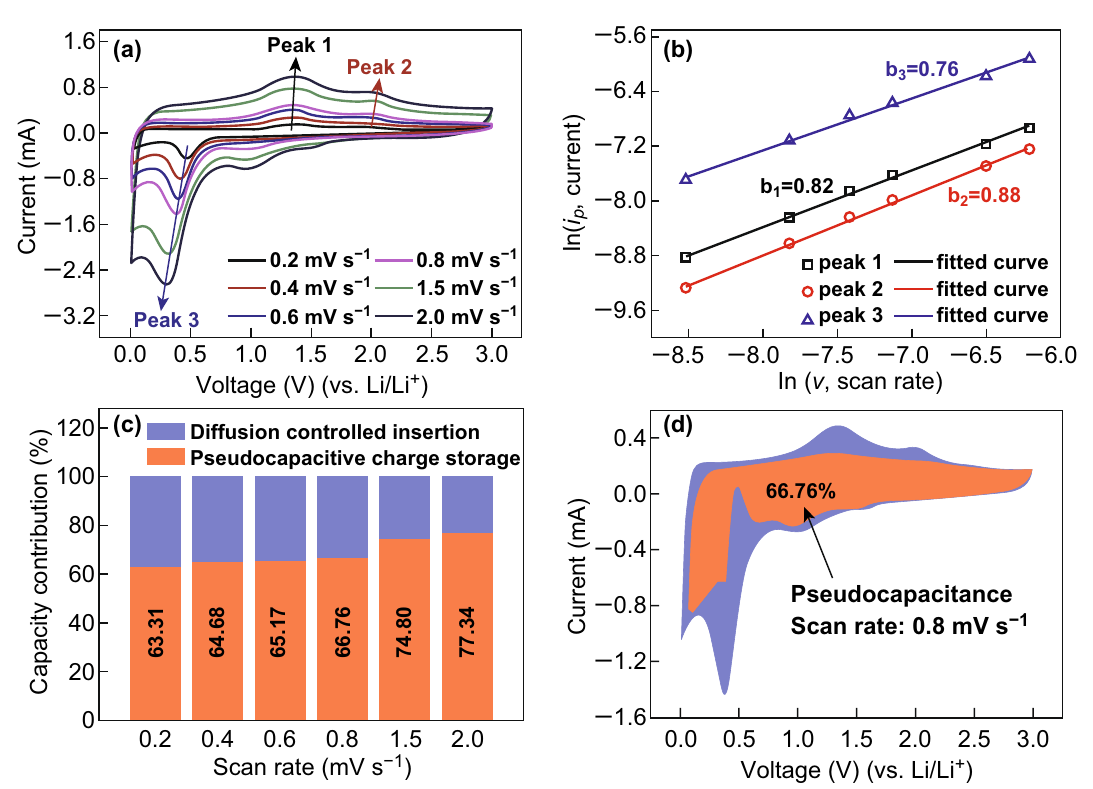
Fig. 7 a CV profiles of the MnO/CoMn 2 O 4 ⊂ GN electrodes at different scan rates with the potential range between 0.01 and 3.0 V. b The fitted lines and ln( i p ) versus ln( v ) plots at different oxidation and reduction states. c The percentages of pseudocapacitive contribution at different scan rates. d Pseudocapacitive (red) and diffusion-controlled (blue) contribution to the charge storage of MnO/CoMn 2 O 4 ⊂ GN at 0.8 mV s −1 . (Color figure